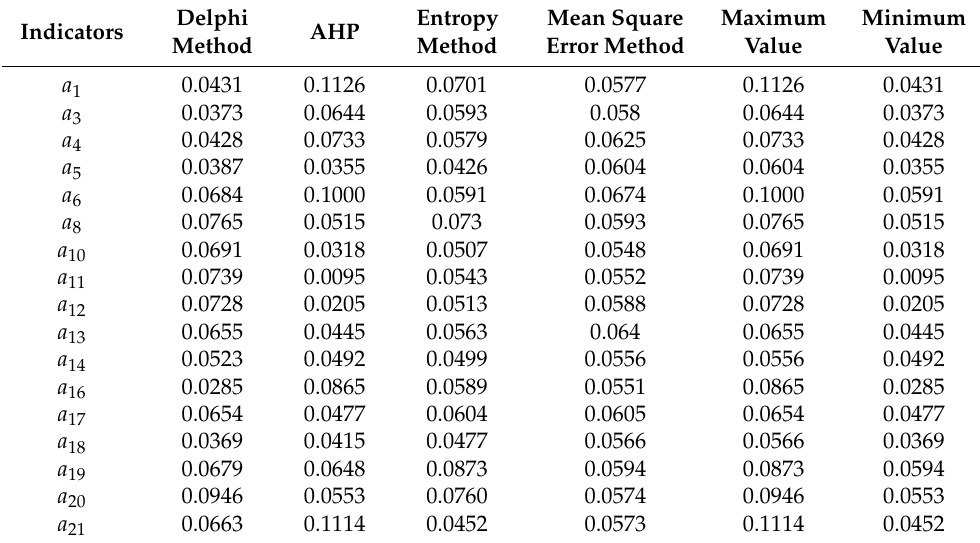
Table 2. Indicator weights calculated based on different weighting